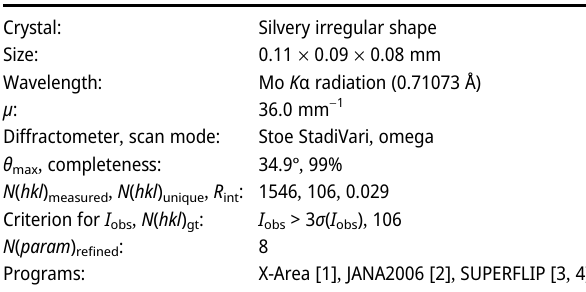
Figure1: Crystal structure ofNbGa 3 (niobiumin blue, the two crystallographically independent galliumsites in magenta).The unit cell is drawnleft. The coordination polyhedra along with the site symmetries are given at the right-hand side. Table  : Data collection and